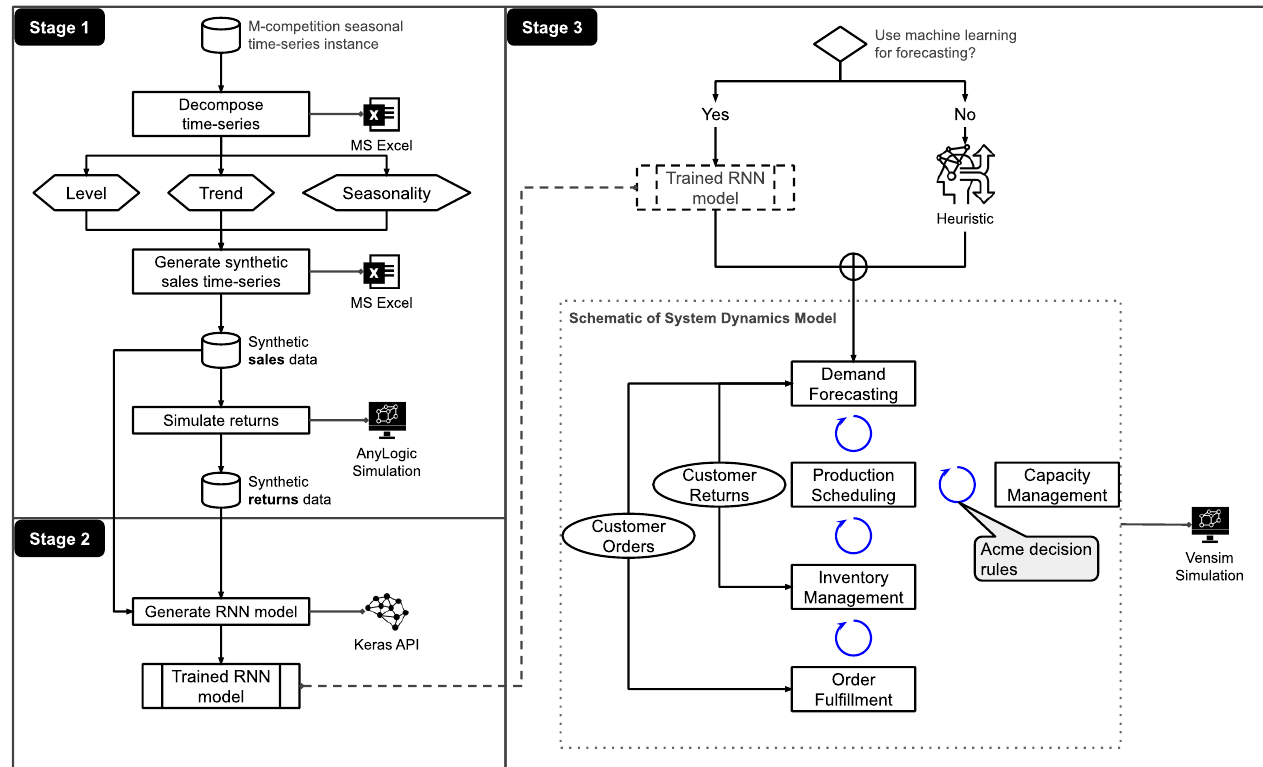
Figure 1. Experimental protocol consists of three stages: generation of synthetic data, creation of the RNN model for predictions, and incorporation of the RNN model in the system dynamics causal model for simulating scenarios for heuristics (human) – ML collaboration .